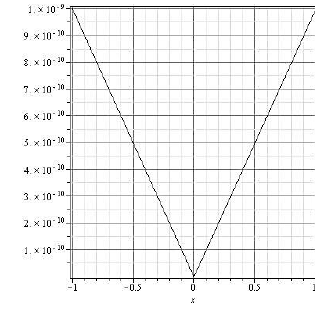
Figure 4. Absolute error of Example 5 ( k = 7).